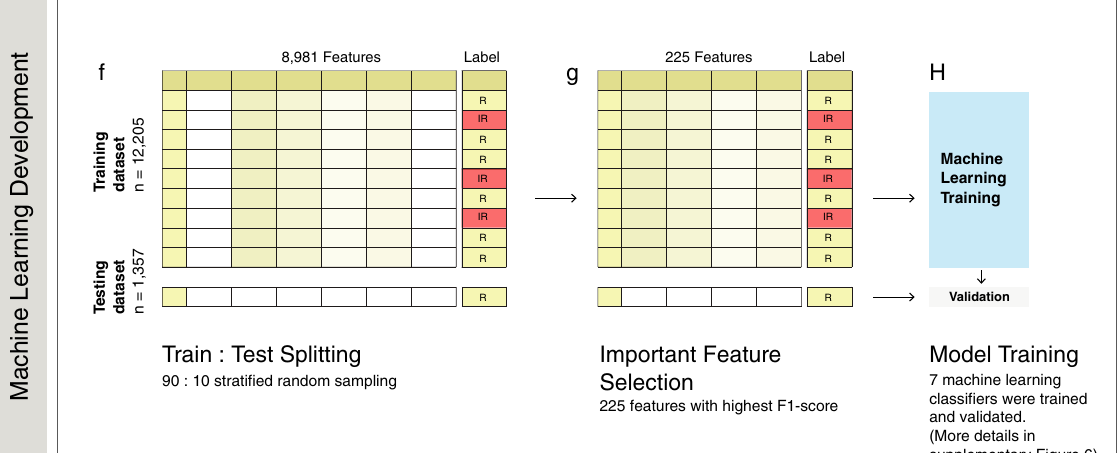
Figure 1. Study protocol to develop machine learning models. ( a ) A high-resolution clinical information was acquired from EMR database. ( b ) Feature construction of ICD10 diagnosis, drug prescription and treatment response labeling. ( c ) Machine learning development